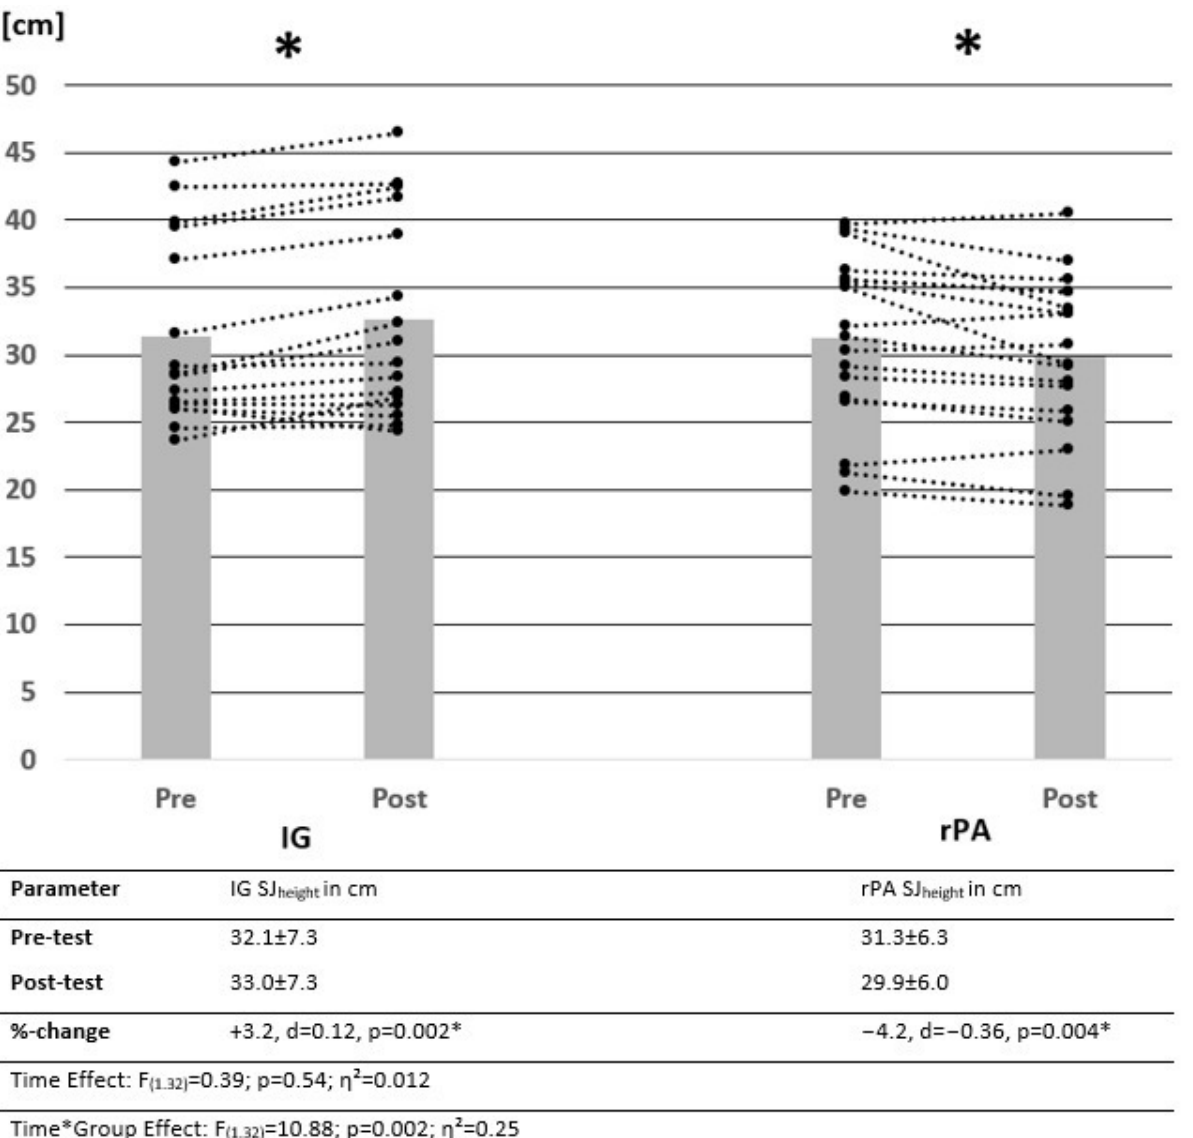
Figure 4. Change in mean values and individual cases of squat jump of control and intervention groups over time. Data presented as means ± SD. IG = intervention group, rPA = reduced physical activity group, SJ = squat jump, * = significantly different from pre- to post-test.